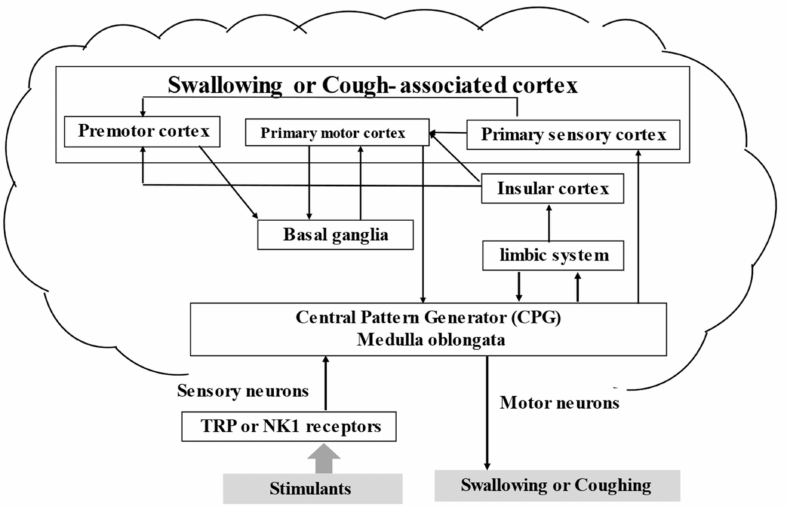
Figure 1. Swallowing, coughing, and the brain. Abbreviations: TRP, transient receptor potential; NK1, neurokinin